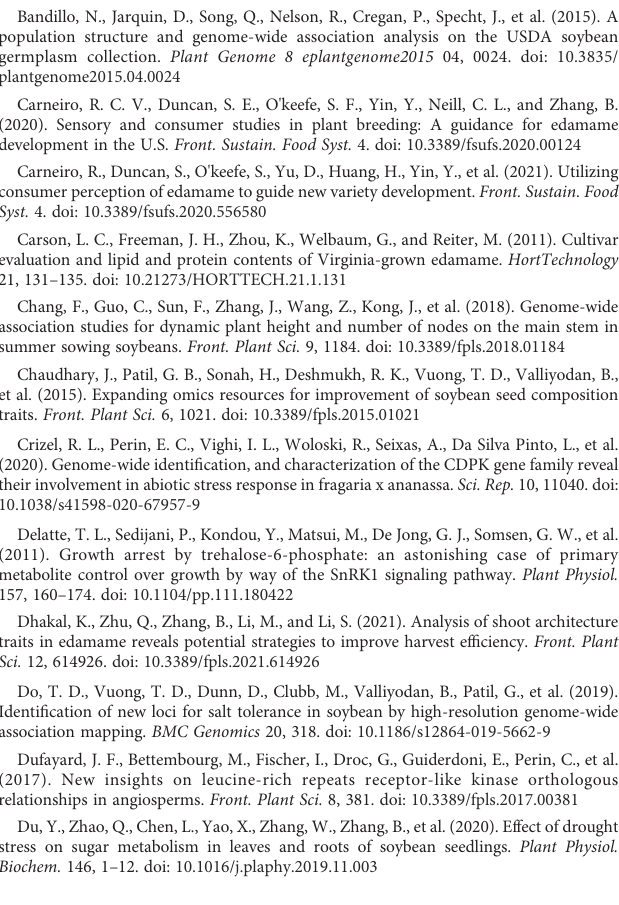
AR, combined, are displayed in Manhattan plots with chromosomes in alternating colors, signi fi cance thresholds-log10(P) > 3.01 (the blue line) and suggestive threshold-log10(P) > 2.70 (the red line). Each respective QQ plot displays observed-log10(P) against expected-log10(P).